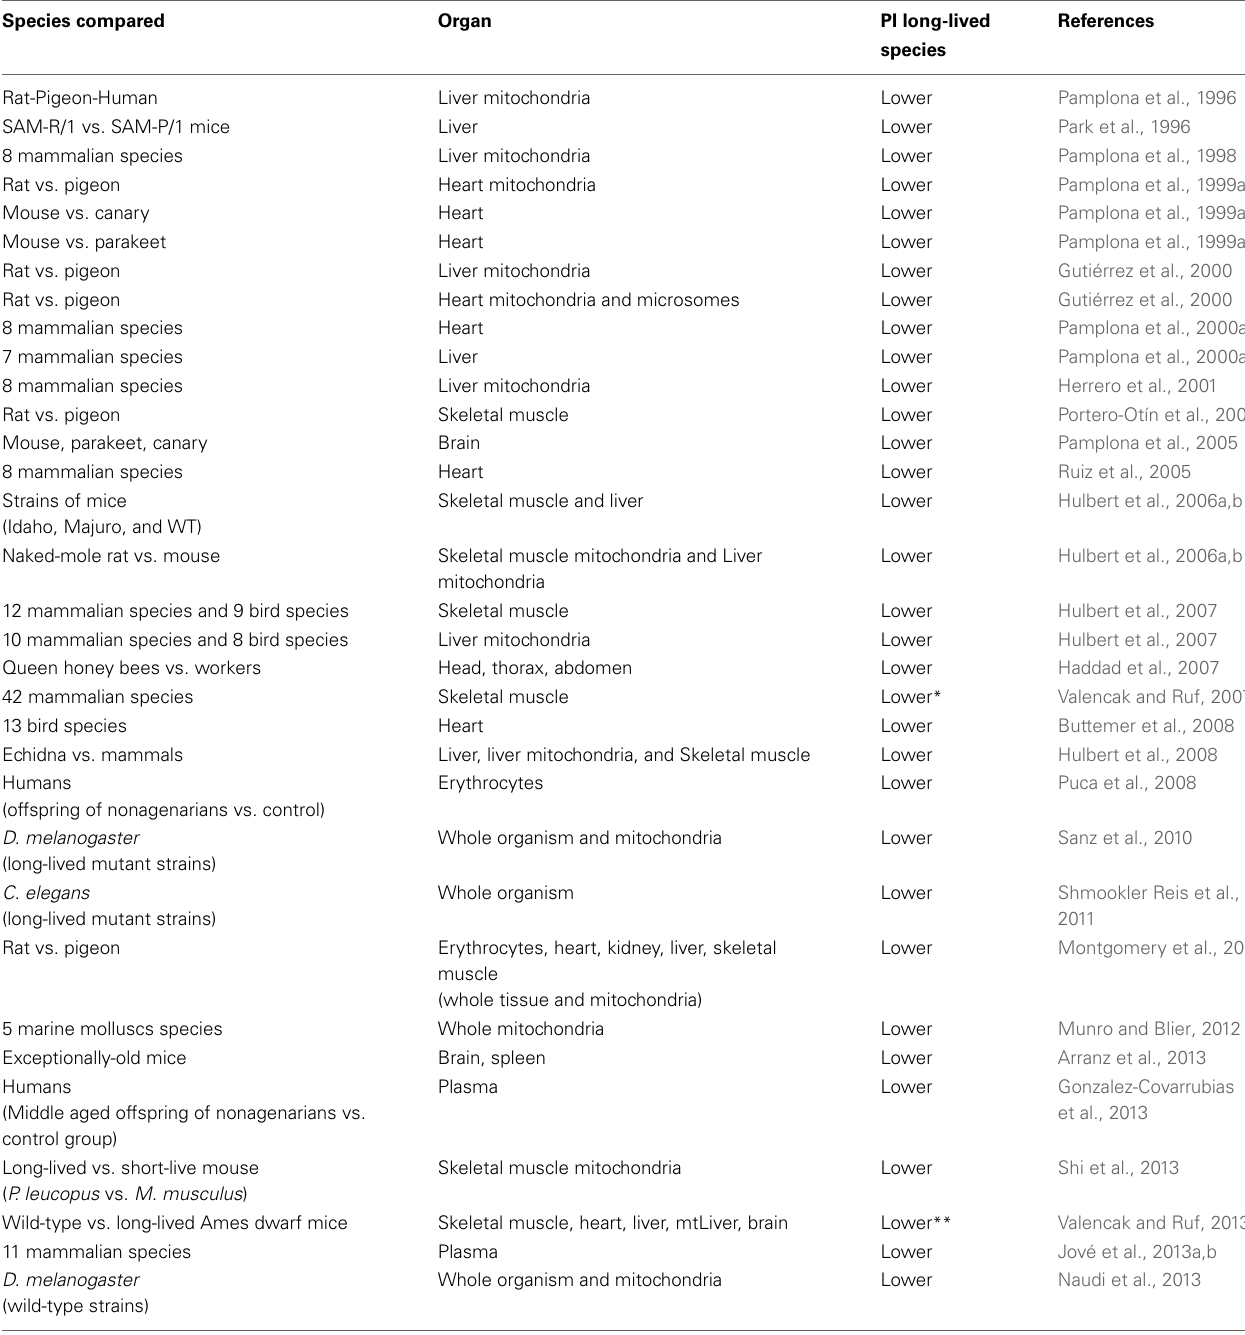
Table 2 | Comparative studies between membrane unsaturation (peroxidizability index, PI) and longevity in animal species (by chronological